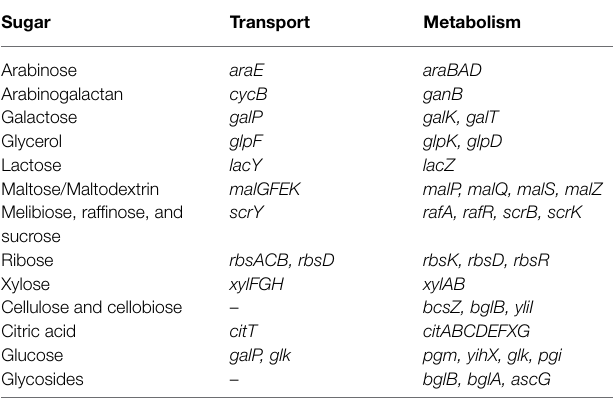
TABLE 2 | Genes identified in the genome of S. plymuthica MBSA-MJ1 involved in sugar transport and